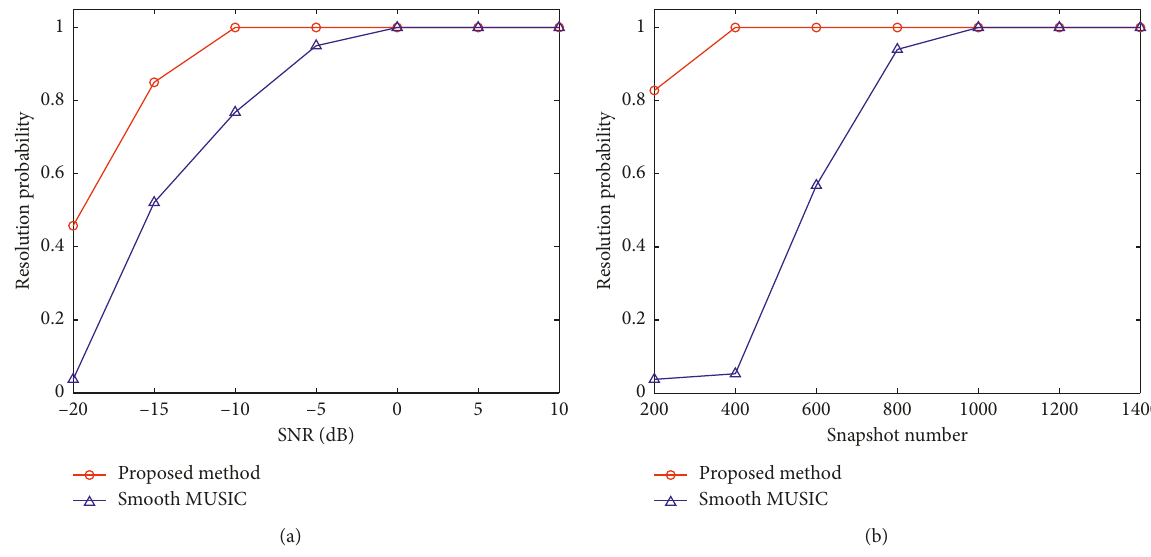
Figure 7: Resolution probabilities versus different parameters. (a) SNR. (b) Snapshot